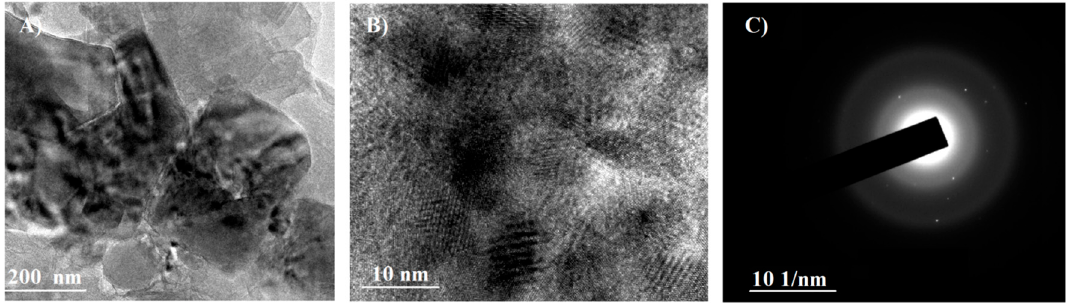
Figure 5. Transmission electron microscopy (TEM) images of Poly( 1 )- b -Poly( DDDPM ) ( A , B ) and SAED pattern ( C ).